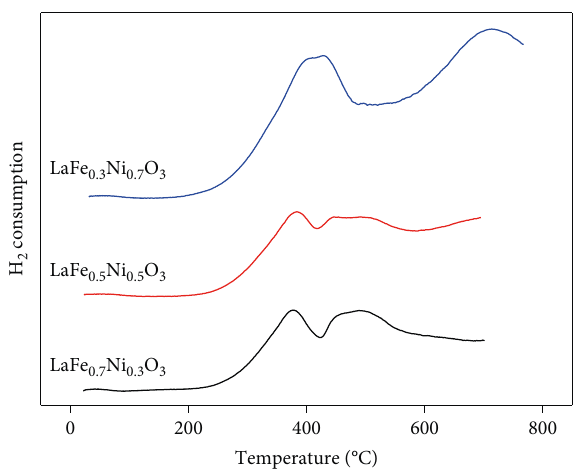
Figure 2: H 2 -TPR profiles of LaFe 1 − x Ni x O 3 ( x